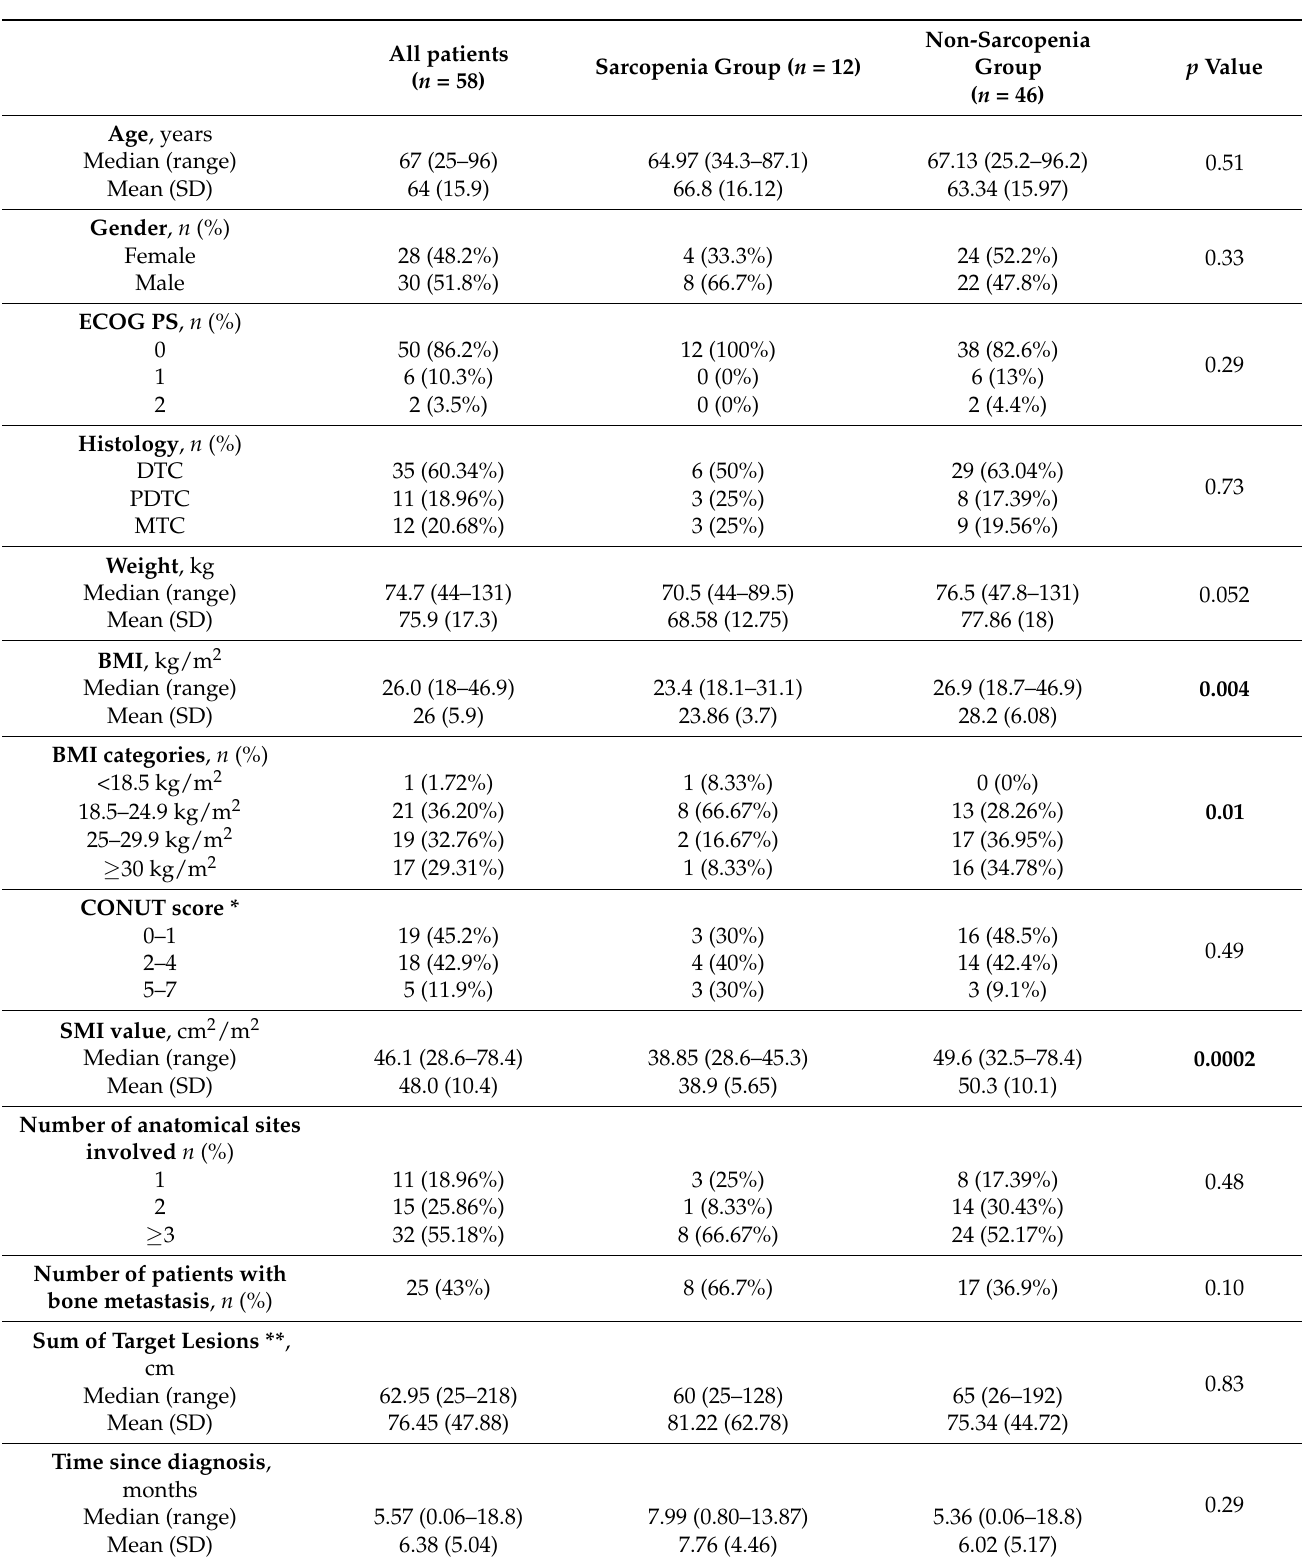
Table 1. Clinical-pathological features of the whole cohort of patients according to the pres- ence/absence of sarcopenia before TKI